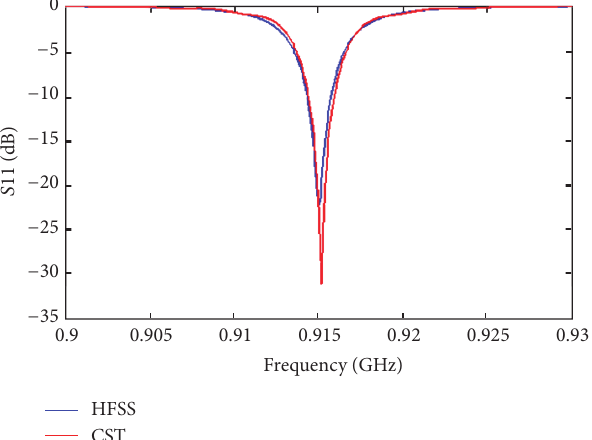
Figure 26: Return loss 𝑆11 of 3D spherical antenna (Table